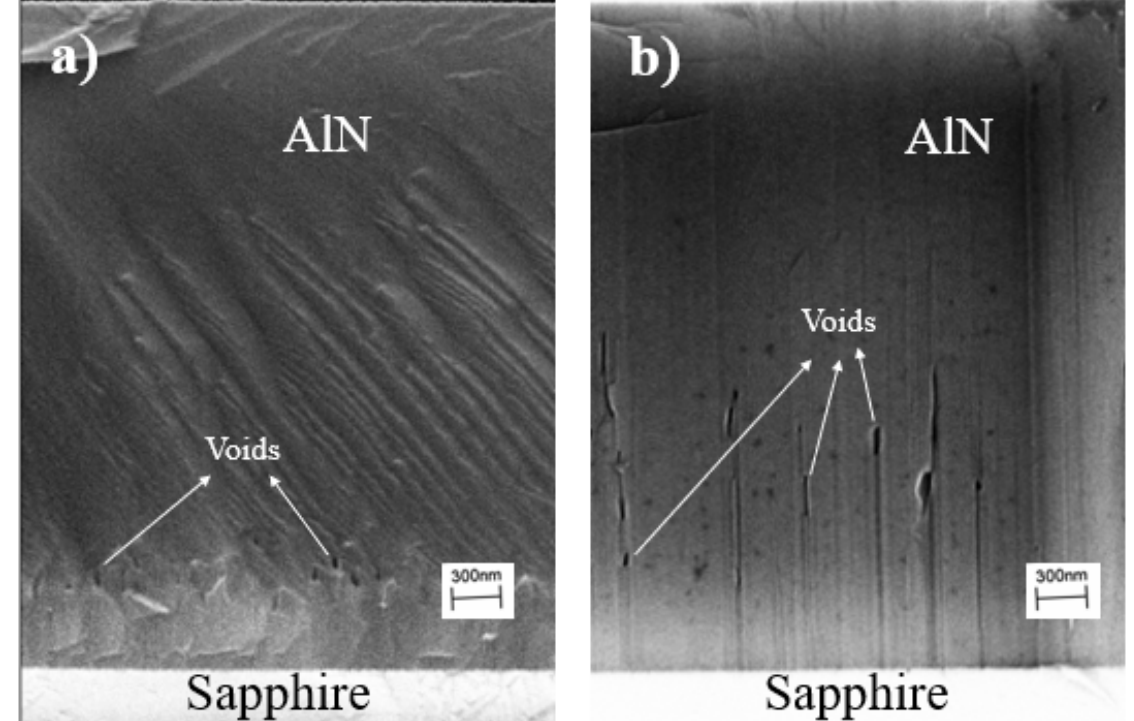
Figure 3. Cross-section SEM images show the voids’ formation for 3 µm thick AlN samples were grown with ( a ) H 2 as a carrier gas and ( b ) N 2 as a carrier gas (Reprinted/adapted with permission from Ref. [9]. 2021, Springer Nature).